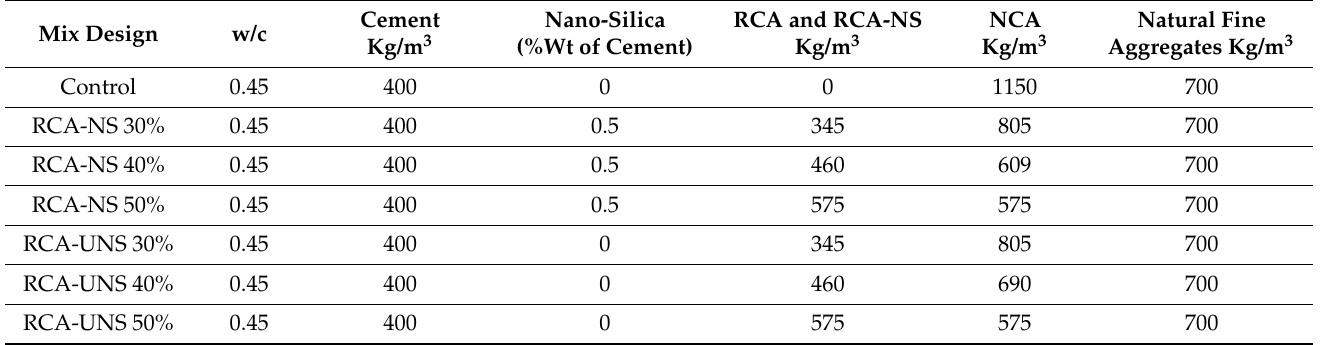
Table 2. Mix design of all samples.